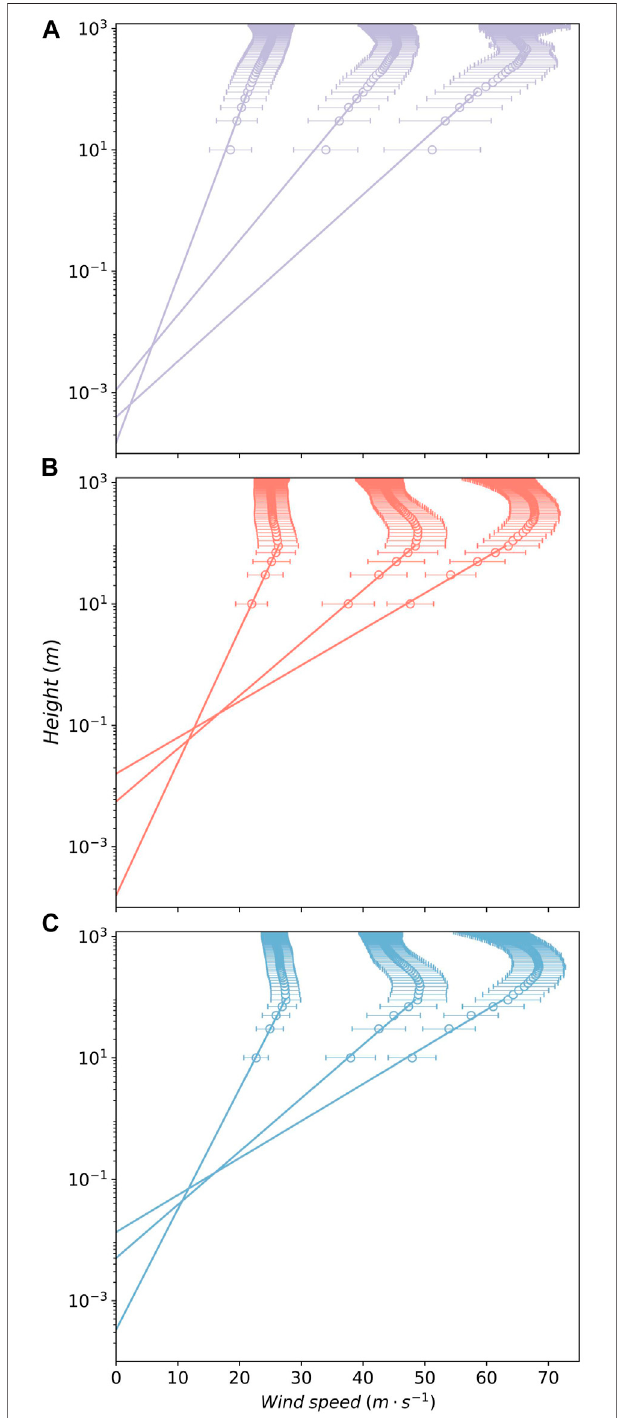
FIGURE 2 | The RD (A) , SD (B), and ID (C) wind pro fi les for the MBW categories of 20 – 29 ms − 1 , 40 – 49 ms − 1 , and 60 – 69 ms − 1 . The line in (B) and (C) isregressed using wind from10to100 m, while thelowest level in (A) was not used for